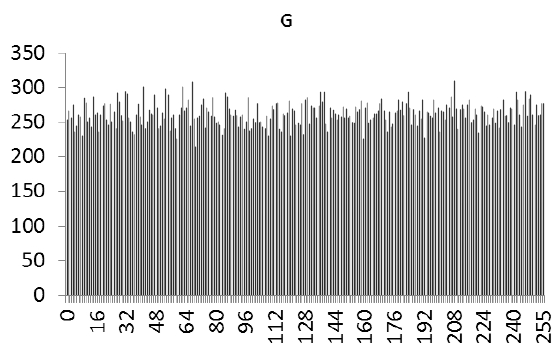
Figure 30. Statistical chart of G value distribution after encryption.